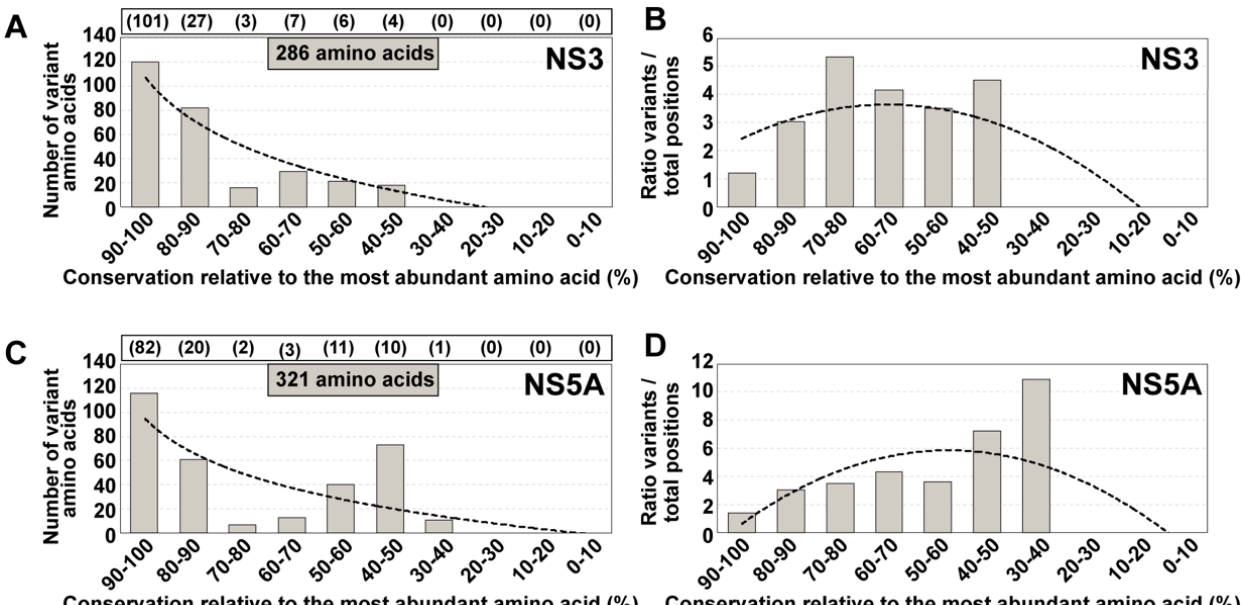
Figure 4. Distribution of positions with variant amino acids identified in HCV from infected patients among amino acid conservation groups according to the LANL amino acid sequence alignment. ( A ) Assignment for the 286 variant amino acids identified within the 148 amino acid stretch comprised between amino acids 32 to 179 of NS3. Conservation groups are indicated in abscissa, and the number of variants in each group is indicated in ordinate. The total number of amino acids that fall in each conservation category in the LANL alignment is indicated in parentheses in the upper box. The discontinuous line corresponds to function y = − 51.97 ln(x) + 107.1 (R 2 = 0.8821). ( B ) Same as ( A ), but with values normalized to the number of residues in each conservation group. The defining function is y = − 0.1385x 2 + 1.0988x + 1.4585 (R 2 = 0.6001). ( C , D ) same as ( A , B ) but for 321 variant amino acids identified within the 129 amino acid stretch comprised between amino acids 24 to 152 of NS5A. The defining functions are: ( C ): y = − 41.41ln(x) + 94.654 (R 2 = 0.5865); ( D ): y = − 0.2979x 2 + 3.1082x − 2.2008 (R 2 = 0.4371). The complete list of deduced amino acid substitutions recorded in the HCV-infected patients is given in Table S1 of